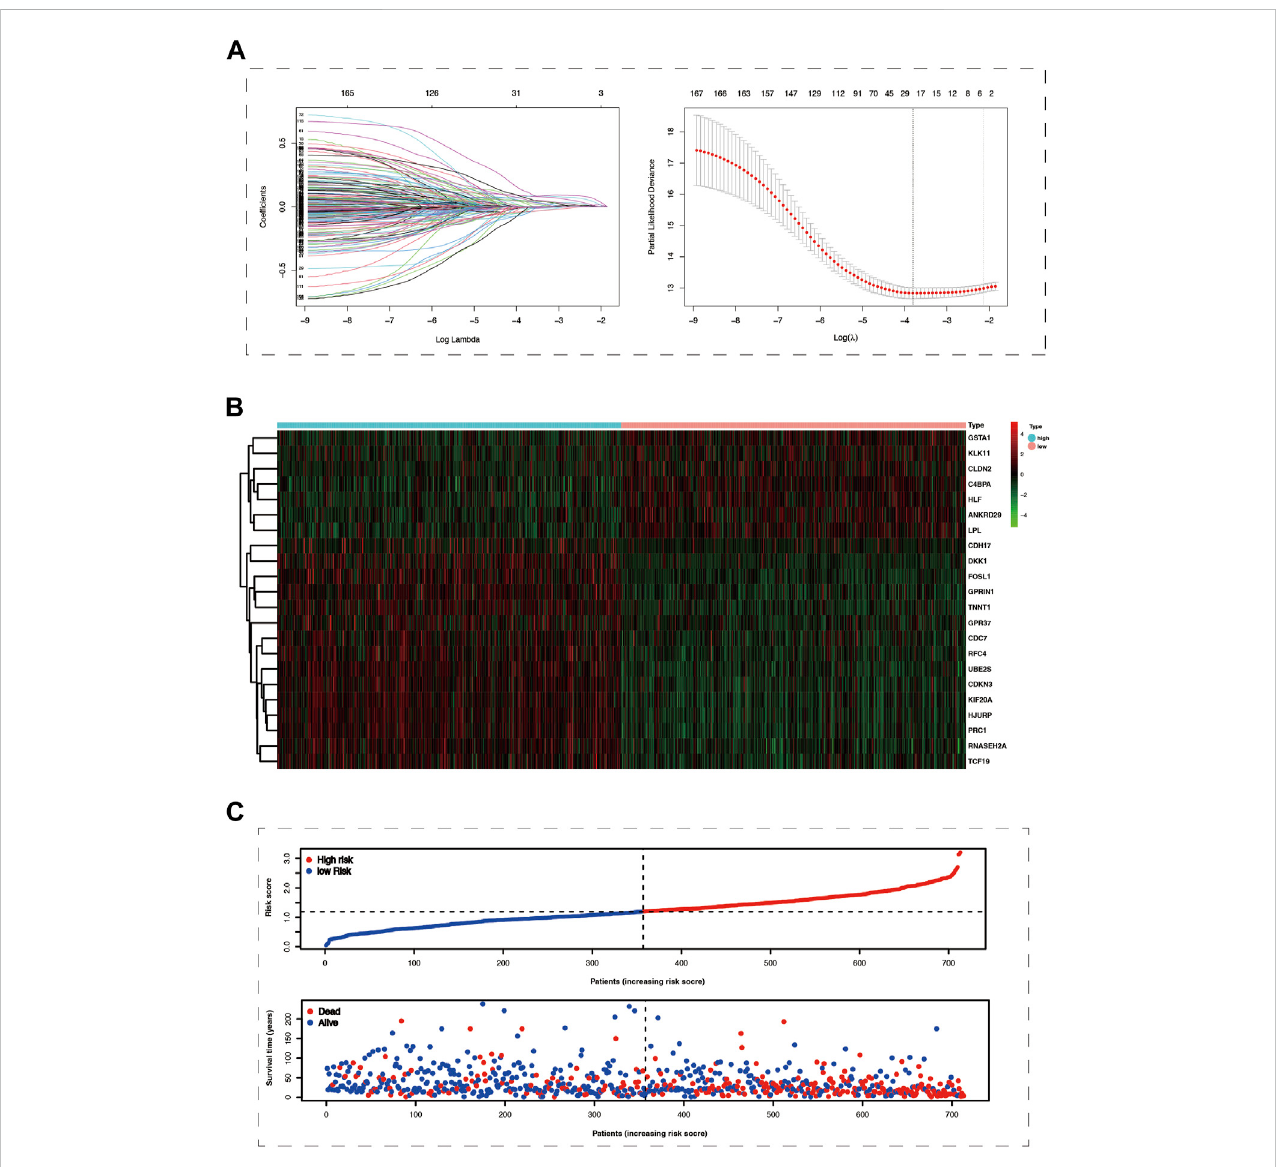
FIGURE 3 The Prognostic model was constructed using cox lasso method in the merge cohort. (A) The left part of picture showed the coef fi cients of 169 survive- relatedgenesdroppingspeedastheloglambdaincreased.Therightsectionofthe fi gureexhibitedthatpartiallikelihooddeviancewasappliedtoevaluatethe fi tnessoftheprognosticmodel,theminimumvalueamongwhichwouldcorrespondtoaspeci fi cloglambda. (B) TheheatmapshowedthemRNAexpression of22prognosticmodelgenesinthehighandlow-riskgroups. (C) Themoresigni fi cantnumberofdeathsandlowersurvivaltimewererepresentedinthe high-risk